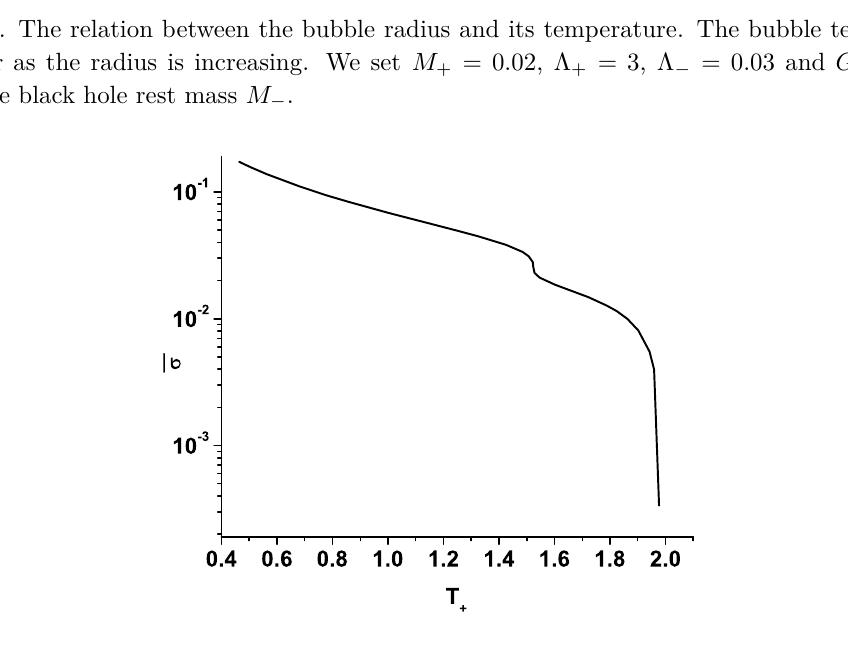
Figure 5 . The relation between the bubble wall’s energy density ( ¯ σ ) and its temperature ( T + ). There is a sharp change at the point where M − = M + , which might indicate a phase transition of some sort. Physically, this represents the critical point where a black hole releases or absorbs energy from the vacuum decay. We set M + = 0 . 02 , Λ + = 3 , Λ − = 0 . 03 and G = 1 , and change the black hole rest mass M −